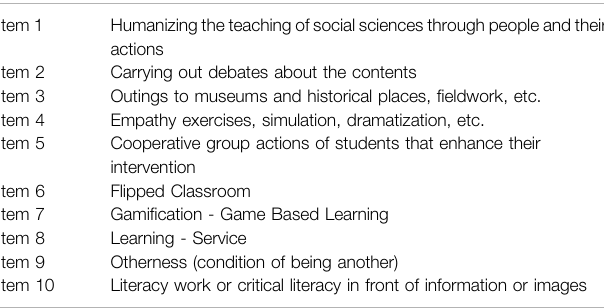
TABLE 2 | Items in Block IV.2 on materials and resources. TABLE 3 | Items in Block IV.3 on teaching